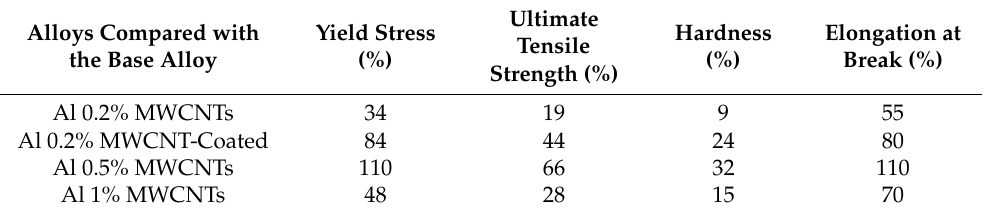
Table 4. Percentage increase in yield stress, tensile resistance, hardness, and elongation of fabricated nanocomposites compared with A356 aluminum